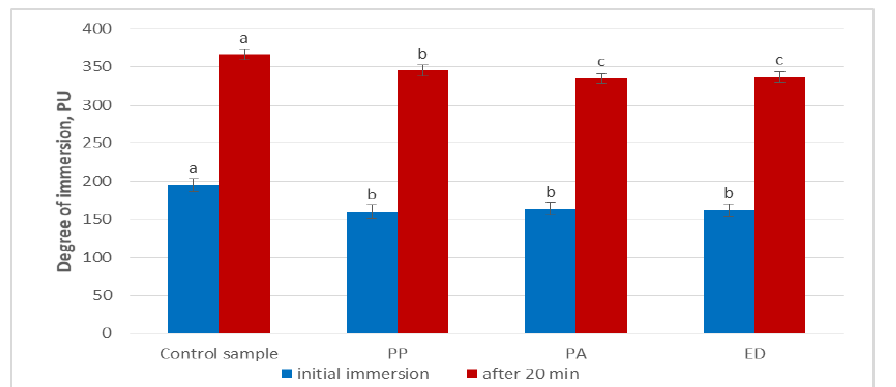
Figure 1. Degree of immersion in nongluten doughs prepared with the addition of sourdoughs with single cultures lactic acid bacteria. Note: PU—penetrometric units; PA—sample with Pediococcus acidilactici 02P108; PP—sample with Pediococcus pentosaceus 12R2187; ED—sample with Enteroccocus durans 09B374. Different small letters for each time measurement indicate significant difference between mean values ( p < 0.01).